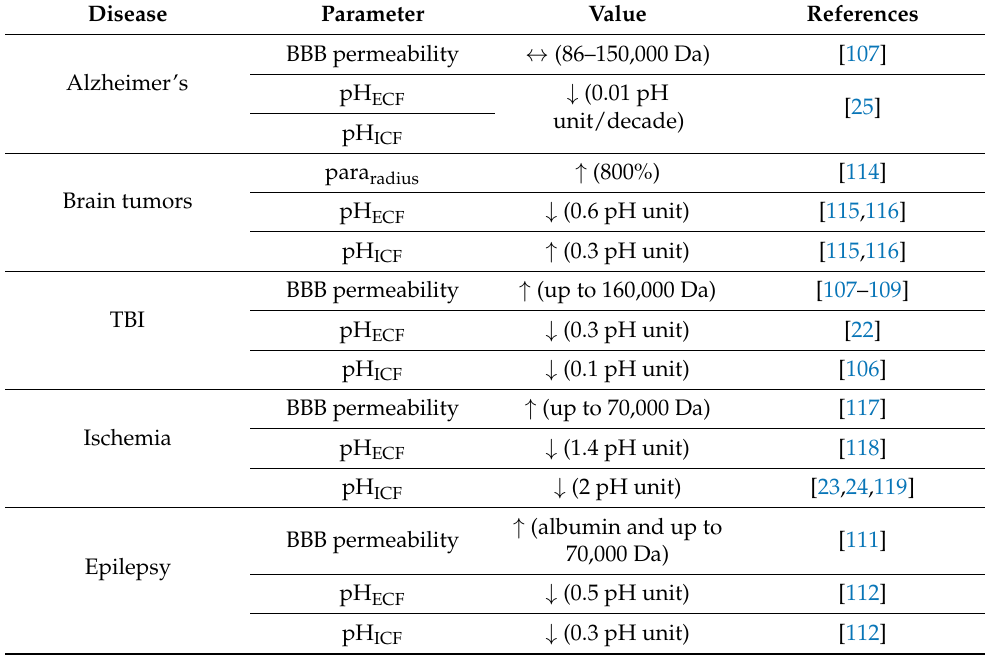
Table 3. Pathophysiological changes of para radius , pH ECF , and pH ICF in multiple CNS